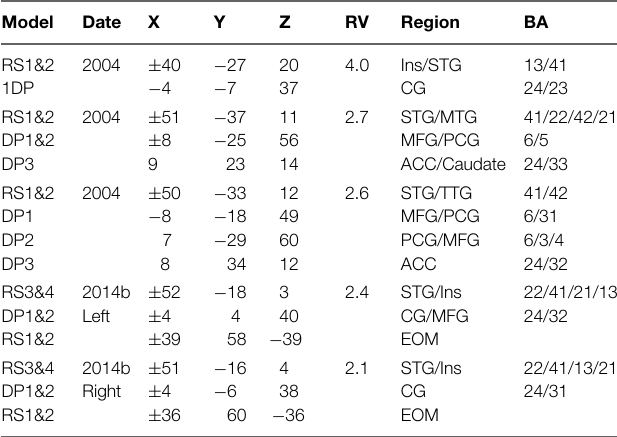
TABLE 1 | Talairach–Tourneaux coordinates (TTCs) for source models for random condition. (Filters 0.2–30 Hz, interval 25–425